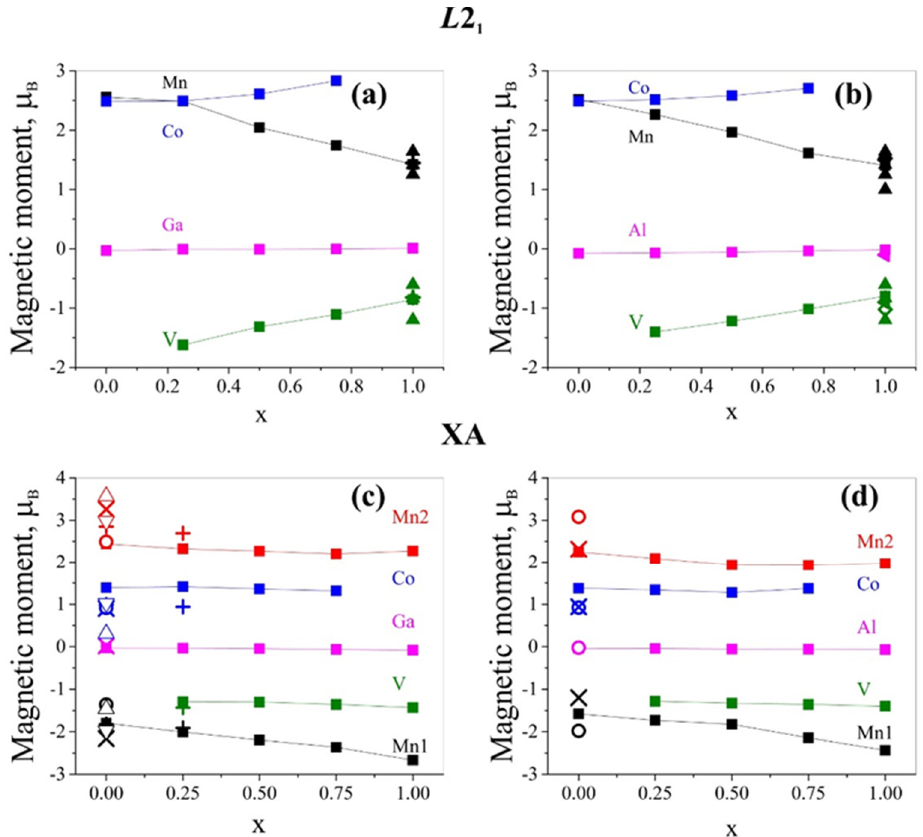
Figure 5. Average values of magnetic moment on atoms calculated by the DDEC6 method on atoms of the Heusler alloy Mn 2 Co 1-x V x Z of the L 2 1 structure ( a ) Z = Ga, ( b ) Z = Al and XA structure ( c ) Z = Ga, ( d ) Z = Al. Literature data are given for comparison: ×—Ref. [2], ○ —Ref. [13], +—Ref. [22], Δ —Ref. [24](theory), ∇ —Ref. [24] (experiment). ◄ [2], ● [35], ◊ —[36], ▲ —[37].